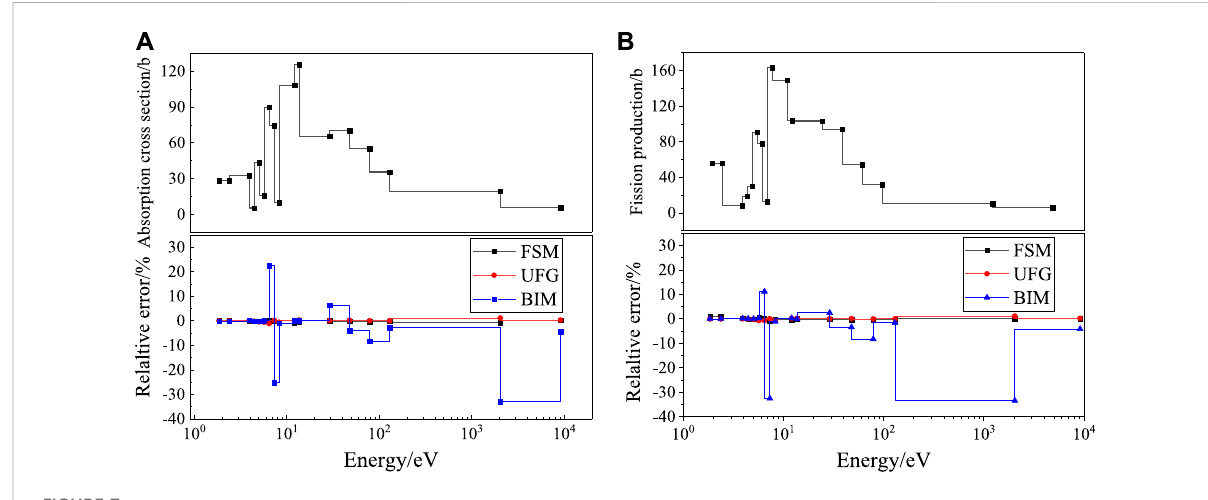
FIGURE 7 Relative deviation of the cross-section for 235 U for the VERA 1B case: (A) absorption; (B) fi ssion production.